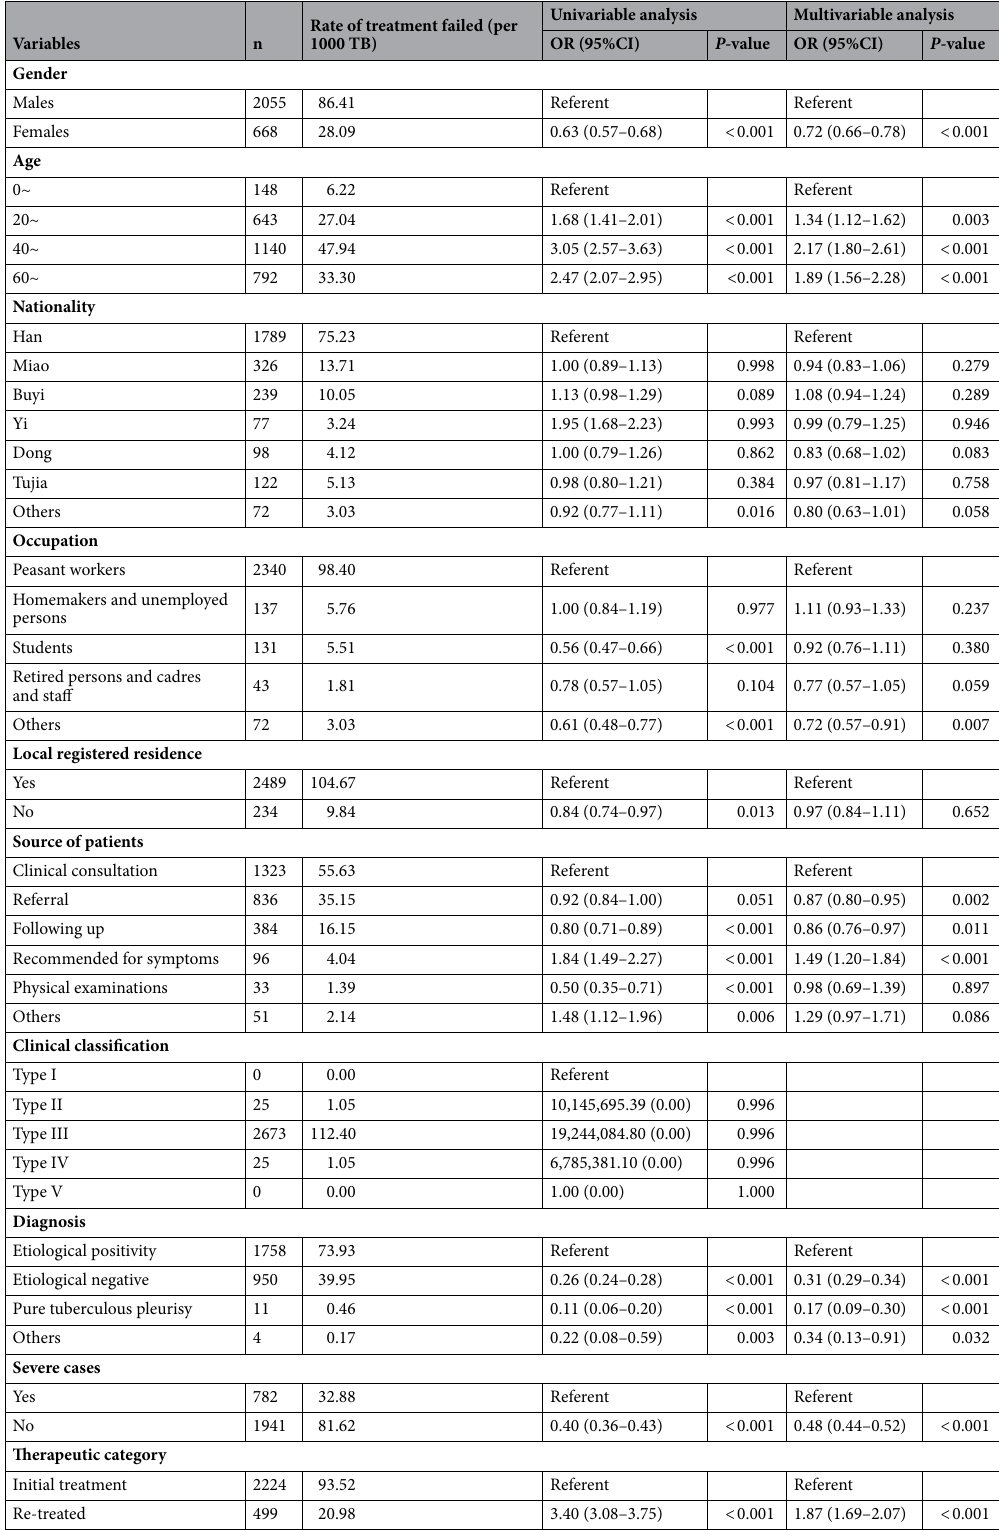
Table 3. Results of risk factors analysis of treatment failed in TB